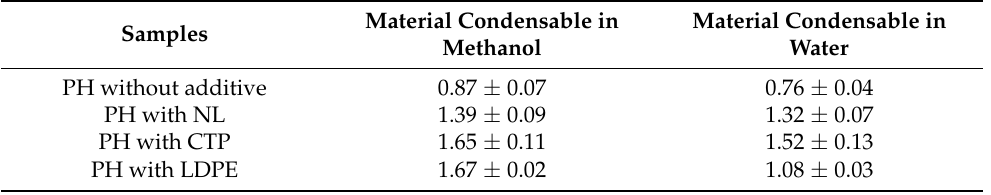
Table 3. The yields of material soluble in methanol and water